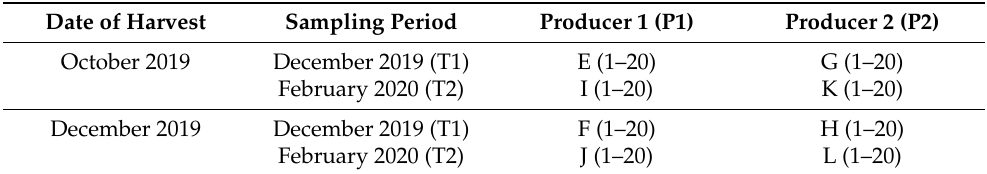
Table 2. Sampling periods and codes used in yeast